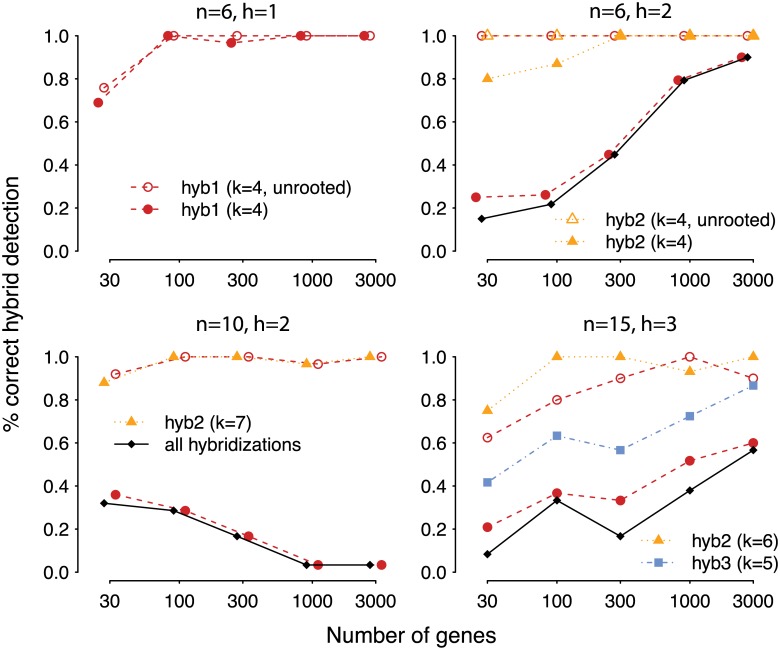
Accuracy of SNaQ to recover each hybridization.proportion of times each reticulation was correctly inferred (connecting the correct donor edge to the correct recipient edge in the major tree), among sequence alignments in which the major tree was recovered. Minor hybrid edges are numbered and colored as in S1 Text. For reticulations creating a cycle of k = 4 nodes, we also calculated the proportion of times that this undirected (or “unrooted”) cycle was correctly inferred, even though the identity and direction of hybrid edges in this cycle might be incorrect (empty symbols). The proportion of times that all hybridizations were correctly inferred (black lines) was low when a single hybridization with k = 4 was hard to recover (bad diamond I in case n = 6, h = 2, and bad diamond II in case n = 10).